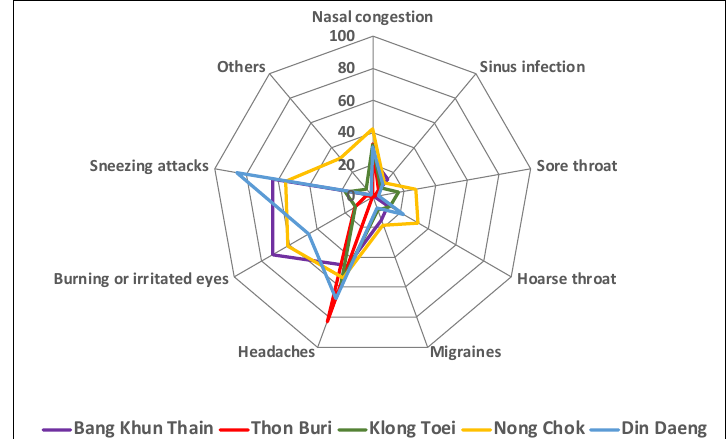
Figure 4. Health symptoms of socio-economic groups among five districts.